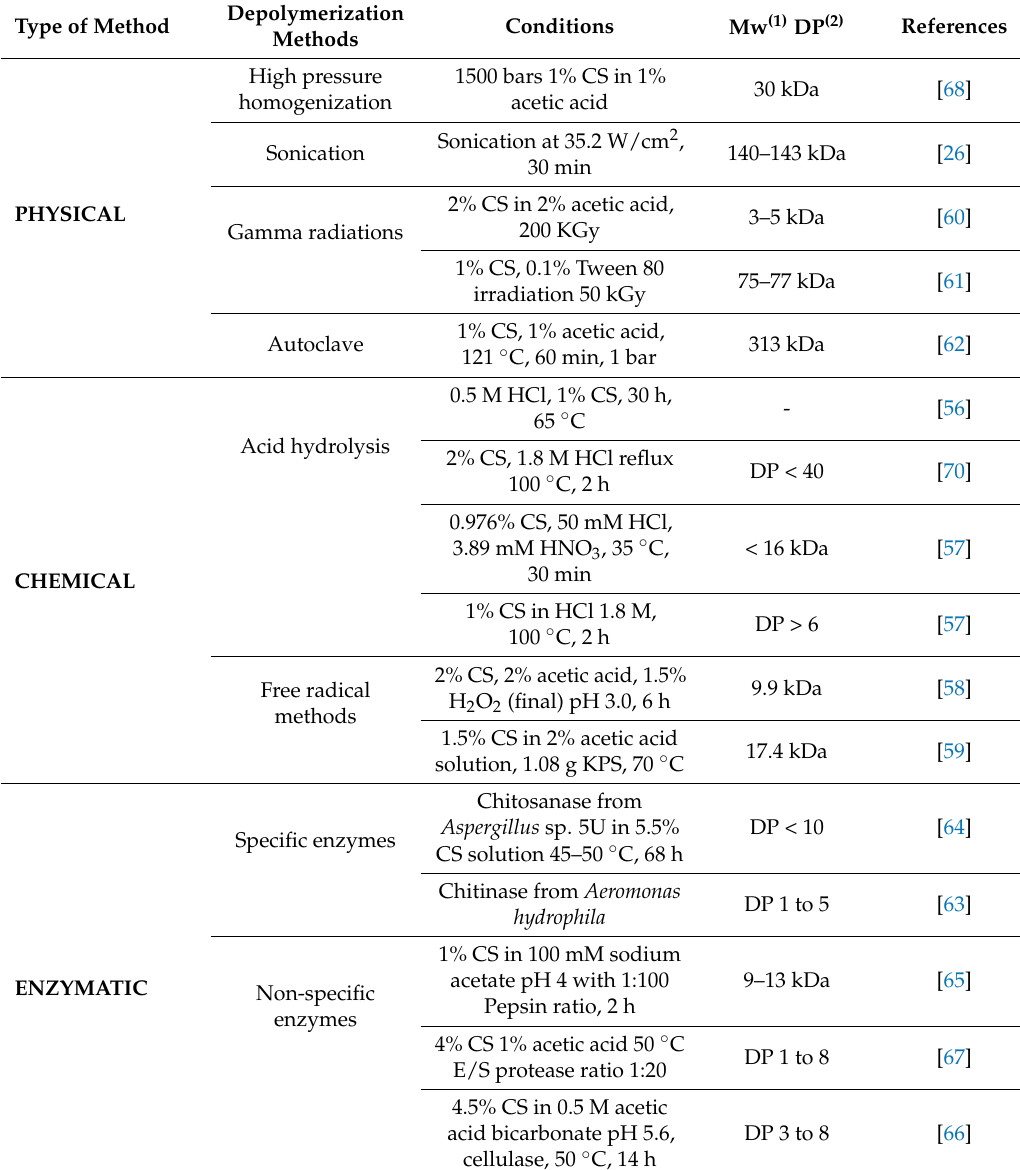
Table 1. Methods reported for producing LMW chitosan or